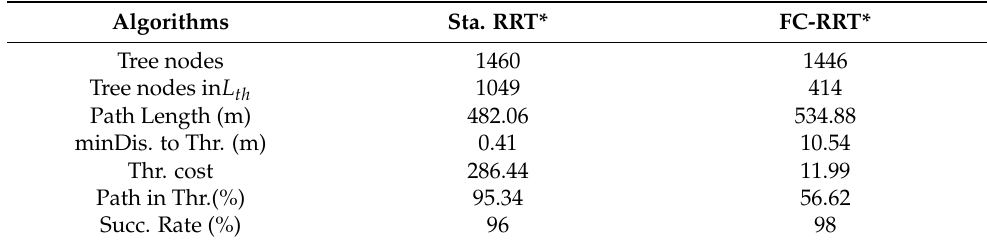
Figure 9. Path comparison of RRT* and FC-RRT* in 3D view.